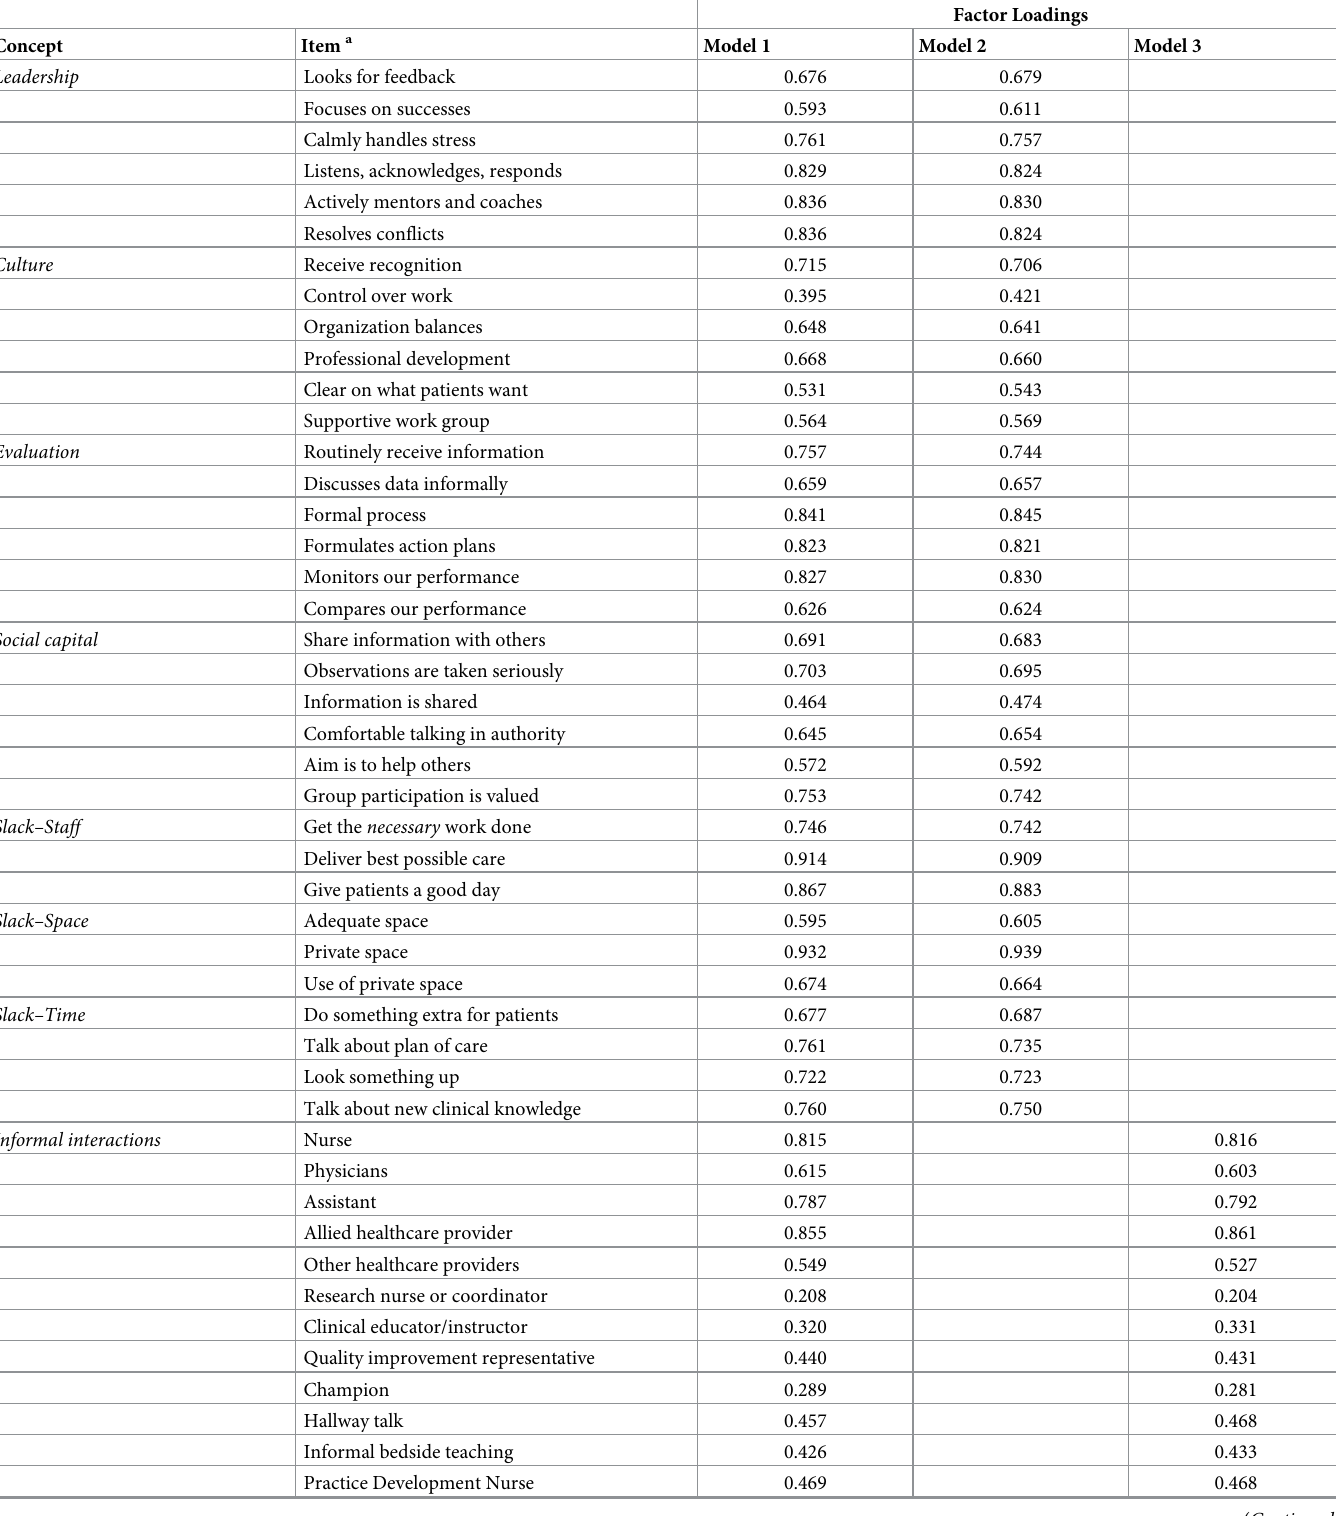
Table 4. Standardized factor loadings and model fit parameters for confirmatory factor analysis (N =